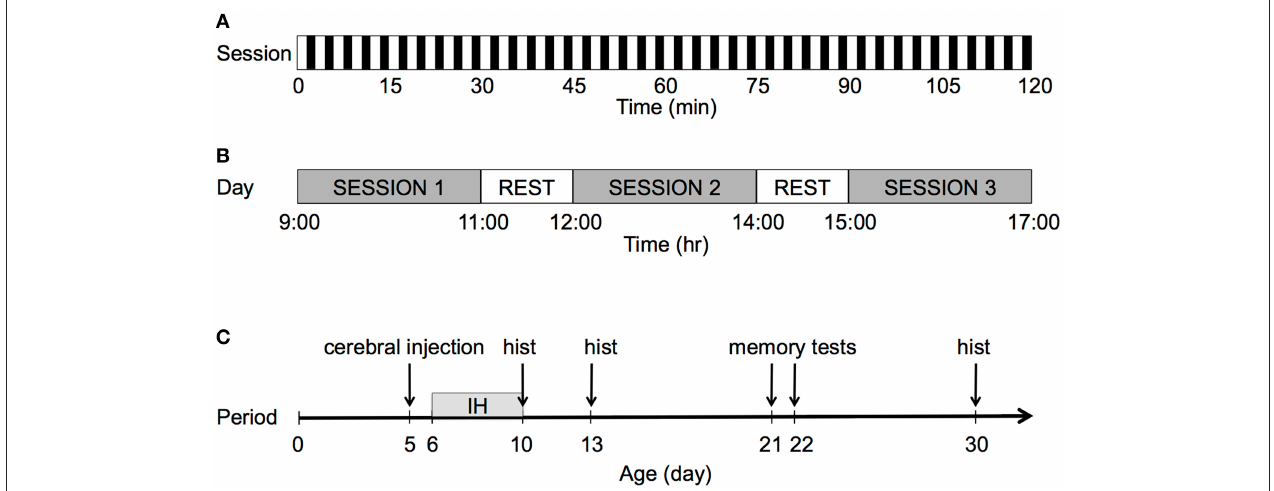
FIGURE 1 | Graphical representation of the IH protocol. (A) Each session lasted 2h with a frequency of 20 events/h. For each hypoxic event, after 90s of normoxia, pure N 2 was injected into the chamber for 30s, which decreased F I O 2 from 20.9 to 8%. F I O 2 was maintained at 8% for 60s. (B) The pups were exposed to IH during three 2-h sessions per day. During rest periods, the pups were returned to their dam for 1h. After completion of the third session, all pups were returned to their dam until the following day. (C) The pups were exposed to IH over 5 consecutive days, from P6 to P10; hist: